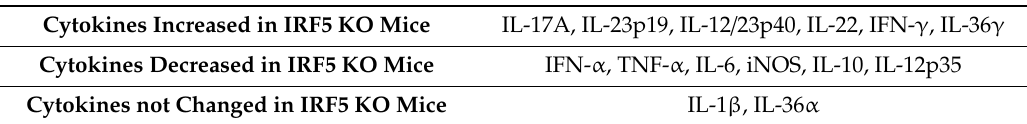
Table 1. The summary of the results of the messenger RNA expression levels in the skin lesions in IRF5 knockout (IRF5 KO) mice compared to wild-type mice.